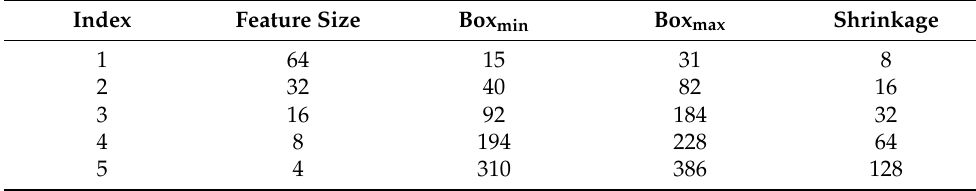
Table 2. Prior boxes setting value. It was set based on the input resolution of 512 × 512. The Box min and Box max values should be gradually expanded when increasing the input